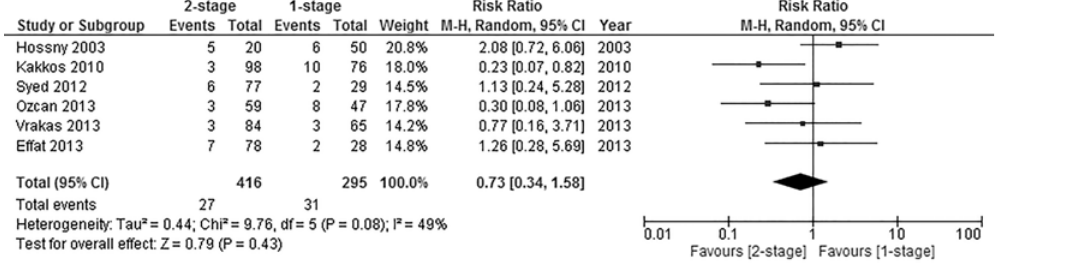
Fig 3. Postoperative Haematoma.